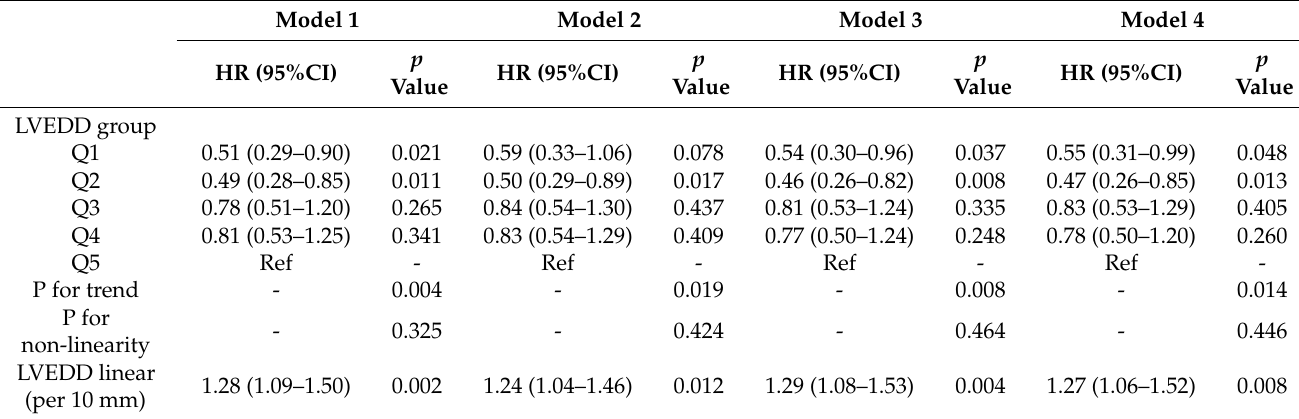
Table 5. Results of competing risk analysis for free from appropriate shock by LVEDD